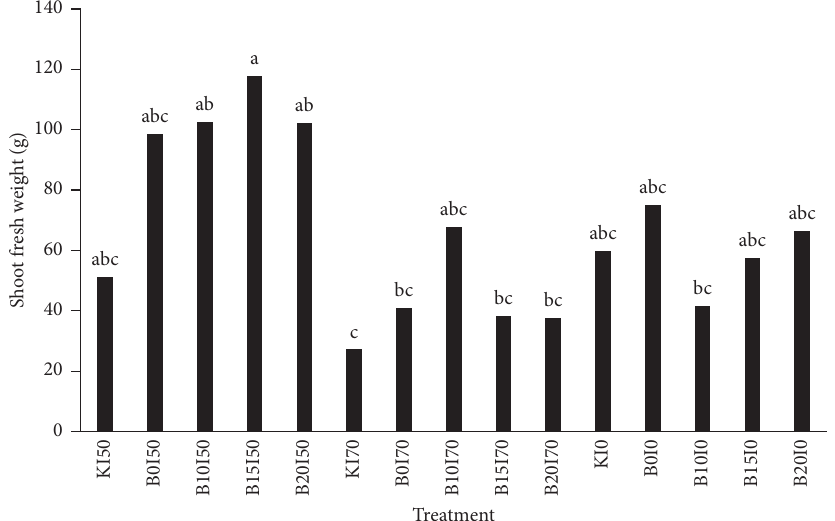
Figure 3: Shoot fresh weight of longevity spinach ( Gynura procumbens ) plants as affected by biochar and shade application.